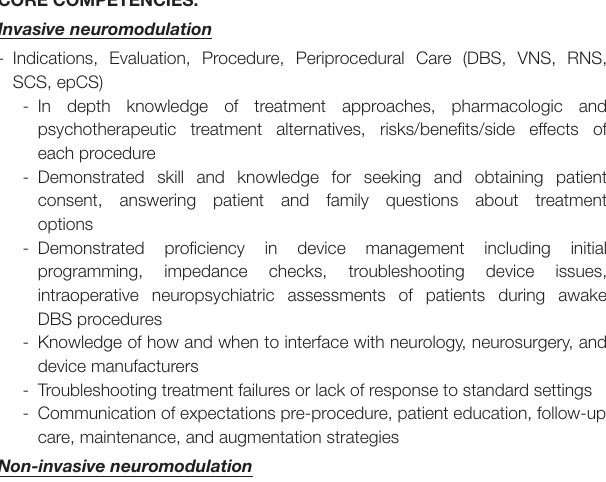
TABLE 1 | Proposed competency areas for trans-disciplinary fellowship in interventional psychiatry or psychiatric neuromodulation. CORE